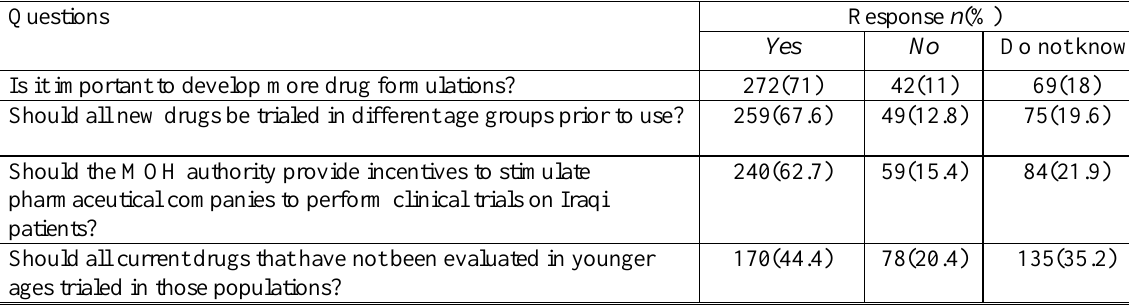
Table 5. Views of the physicians about the need for more drug formulations and trialing all new drugs in different age groups prior to use ( n = 383